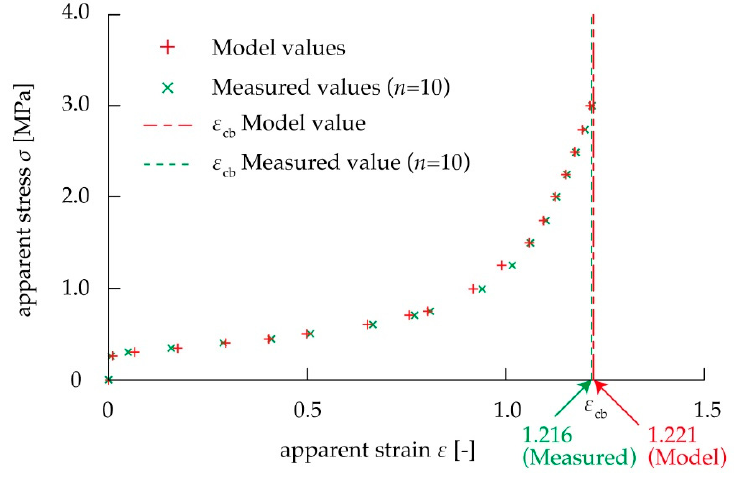
Figure 6. Comparison of values calculated using the spring model and values in the stress–strain diagram from the tensile test for n = 10 using the test piece.